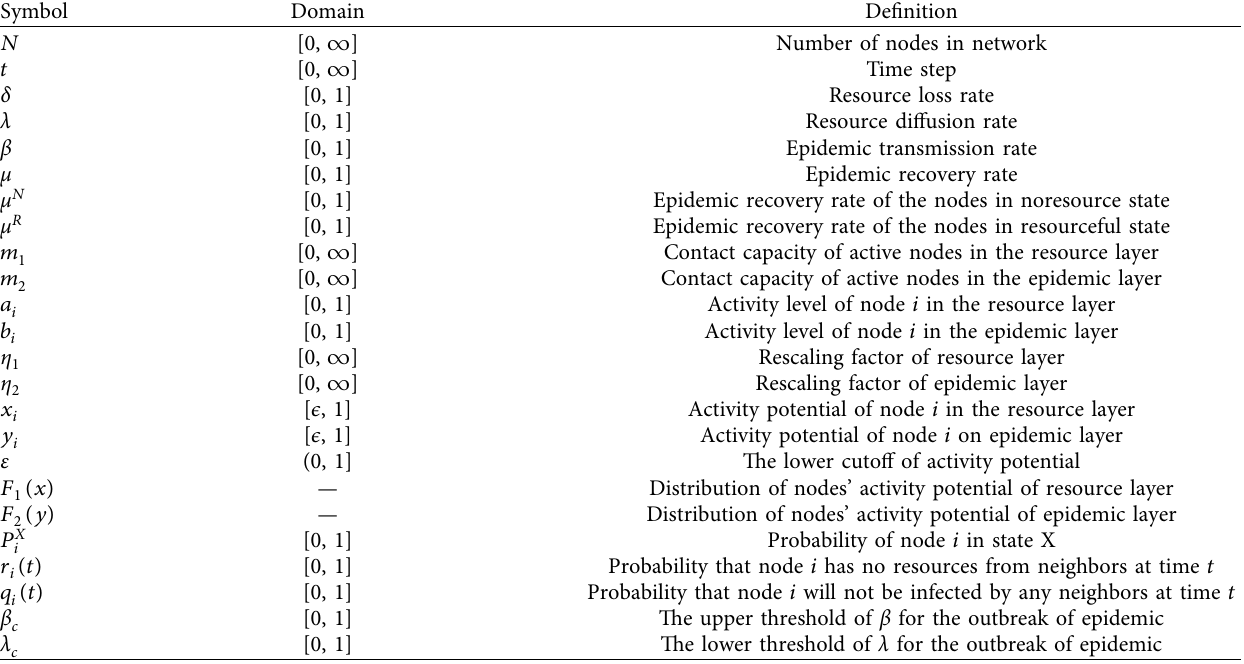
Figure 1: The sketch of coupled RNR-SIS model on an AD temporal two-layer network. The nodes indicate individuals in real society, and the edges depict dynamic contacts and social relationships of individuals in social networks. Individual resources diffuse on the upper layer (i.e., resource layer), leading to the node in a resourceful or noresource state. The spread of disease occurs on the lower layer (i.e., epidemic + Δ t , where node to (b) t layer), leading to the node in a susceptible or infected state. The coupled dynamic process evolves from (a) times t 1 1 2 is infected from its neighbors, node 4 recovers in the epidemic layer, and node 3 changes from the noresource to resourceful state in the resource layer. Table 1: Notions of